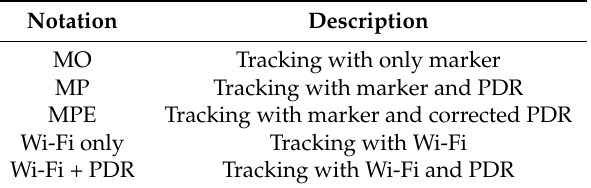
Table 1. Notation summary of tracking accuracy